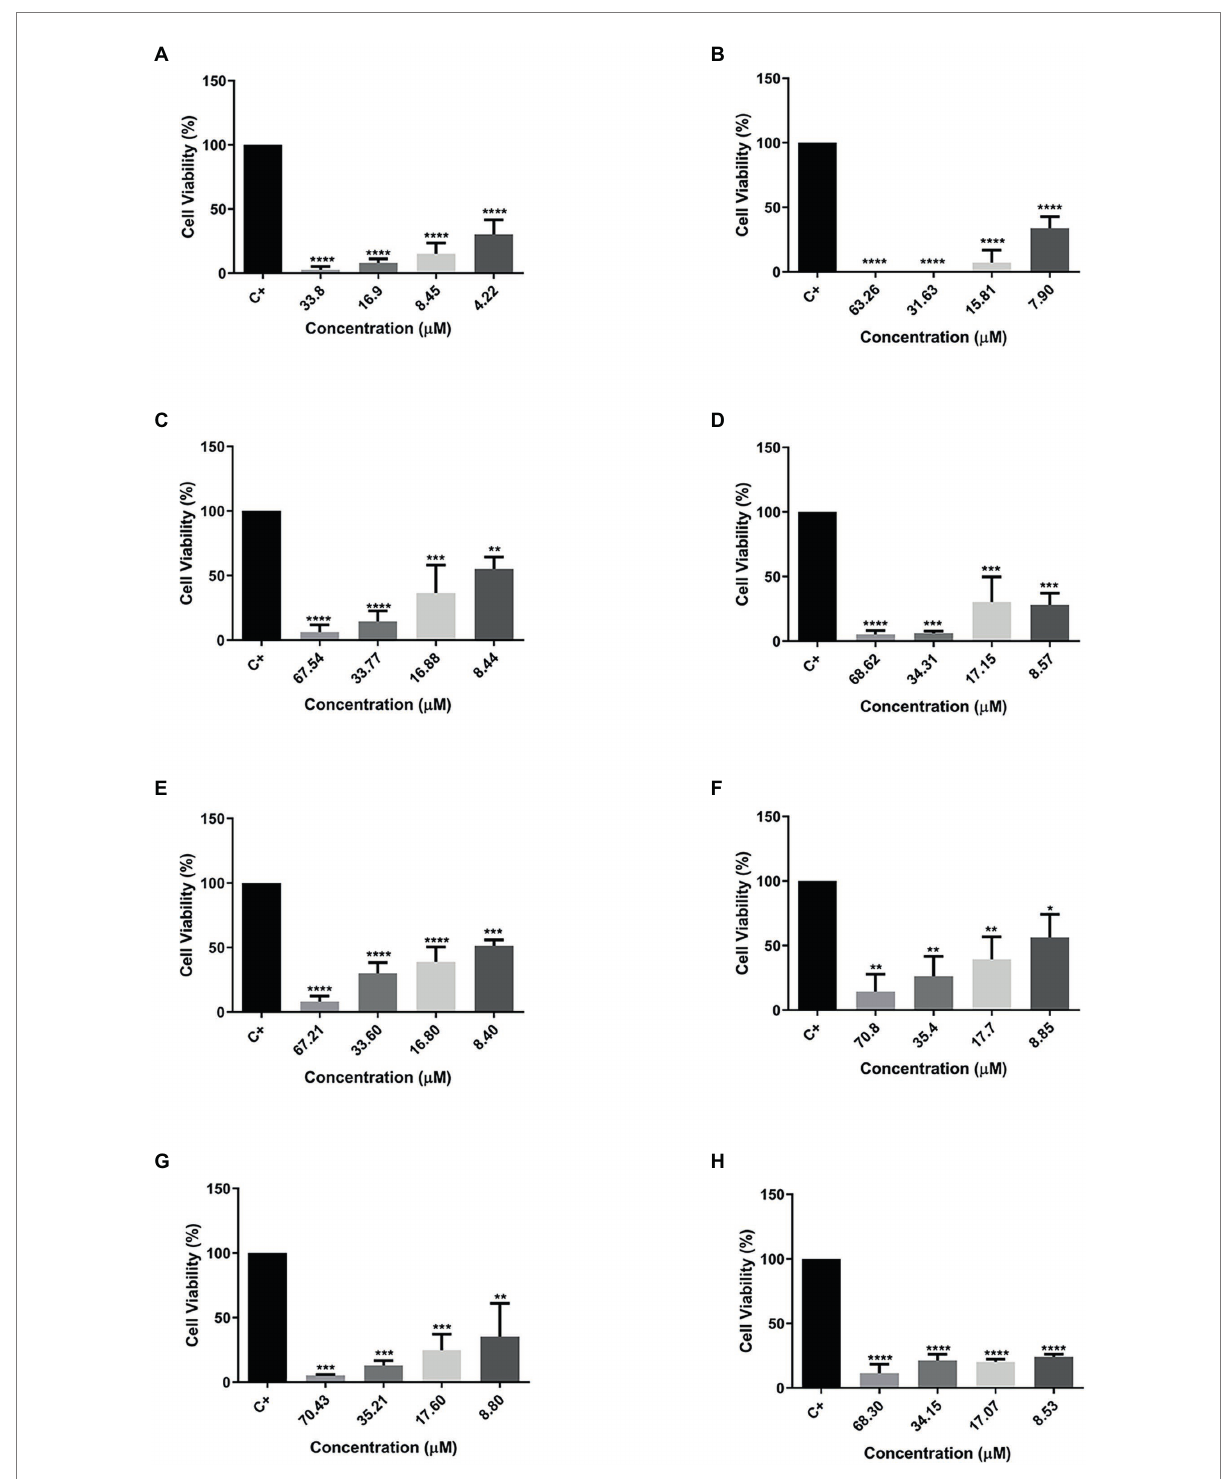
FIGURE 4 Percentage of cell viability in MCF-7 cancer cells. (A) Cu-1a; (B) R1a; (C) R1b; (D) R2b; (E) R3b; (F) R6b; (G) R8b; and (H) R10b. One-way ANOVA— Bonferroni’s multiple comparisons test. Each bar represents the mean ± SD of cellular absorbance; N = 3. * p < 0.05, ** p < 0.01, *** p < 0.001, **** p < 0.0001, and NS p >